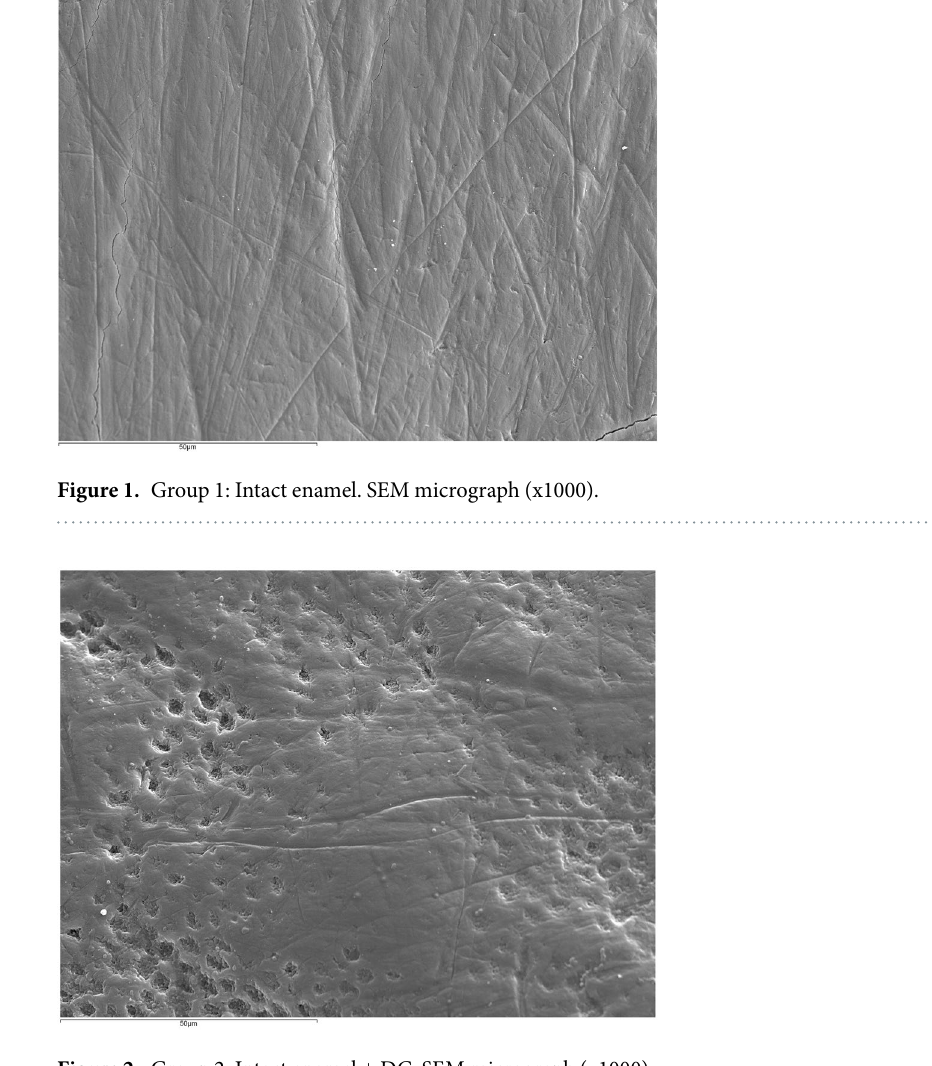
Figure 2. Group 2: Intact enamel + DC. SEM micrograph (x1000).